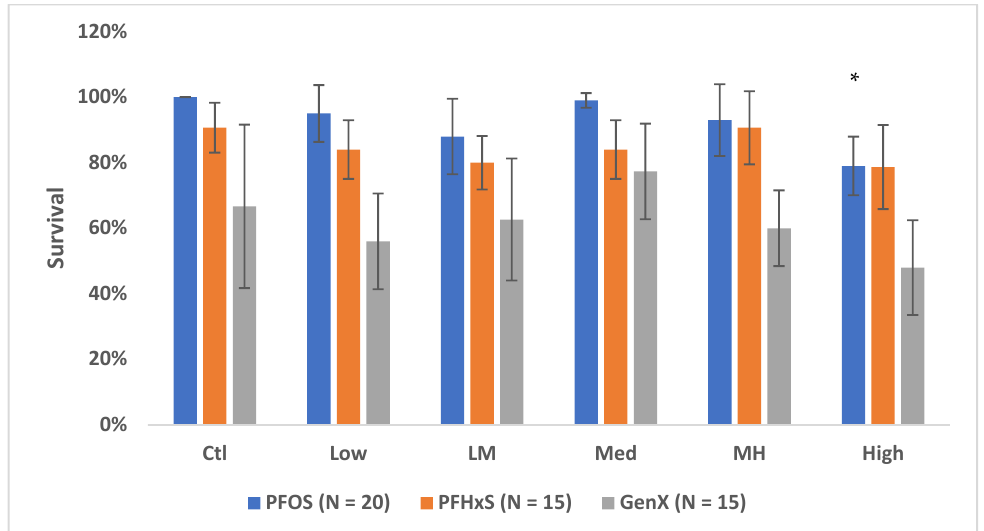
Figure 1. Mean (±SD) survival of amphipods Austrochiltona subtenuis following exposure to different concentrations of PFOS, PFHxS and GenX for 7 days. Two-tailed t -test between control and concen- tration revealed survival of amphipods were significantly reduced ( p = 0.00) * at the highest PFOS concentration. Ctl = control, LM = low – medium, and MH = medium – high.